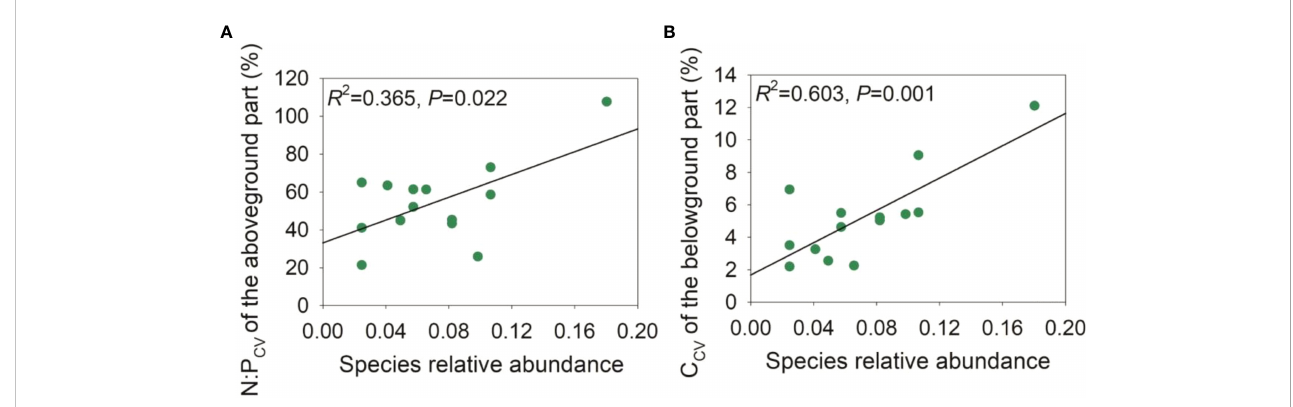
FIGURE 6 Relationships between species relative abundance and intraspeci fi c variation of plant C:N:P stoichiometries in the late growth stage. (A) , relationship between intraspeci fi c variation of N:P (N:P CV ) of the aboveground part in relation to species relative abundance; (B) , relationship between intraspeci fi c variation of C concentration (C CV ) of the belowground part in relation to species relative